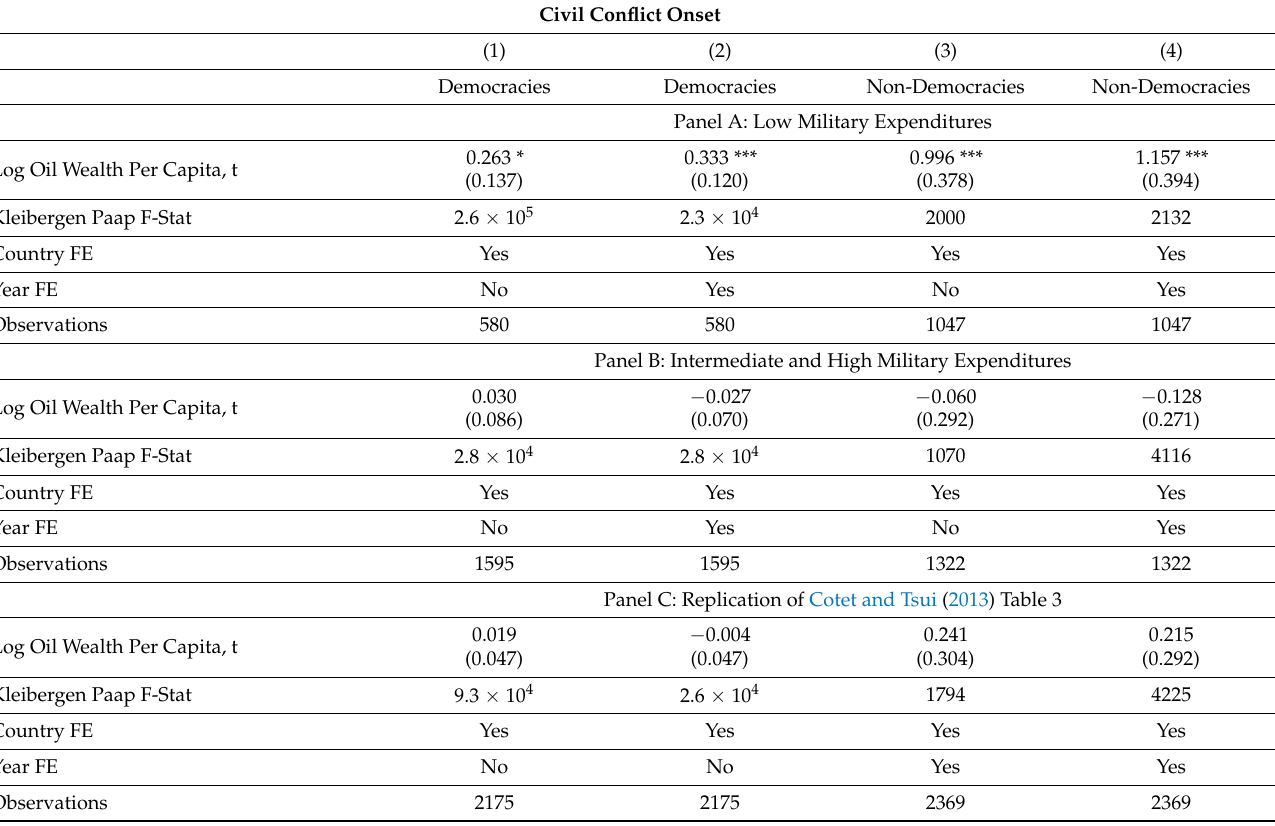
Panel C: Replication of Cotet and Tsui (2013) Table